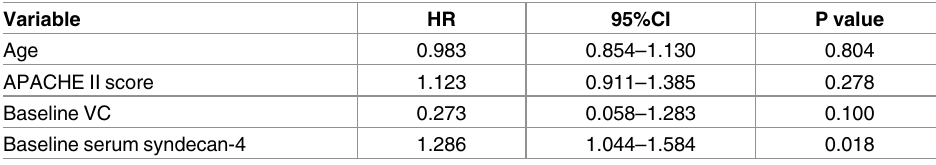
Table 6. Multivariate analysis of survival prediction. Multivariate